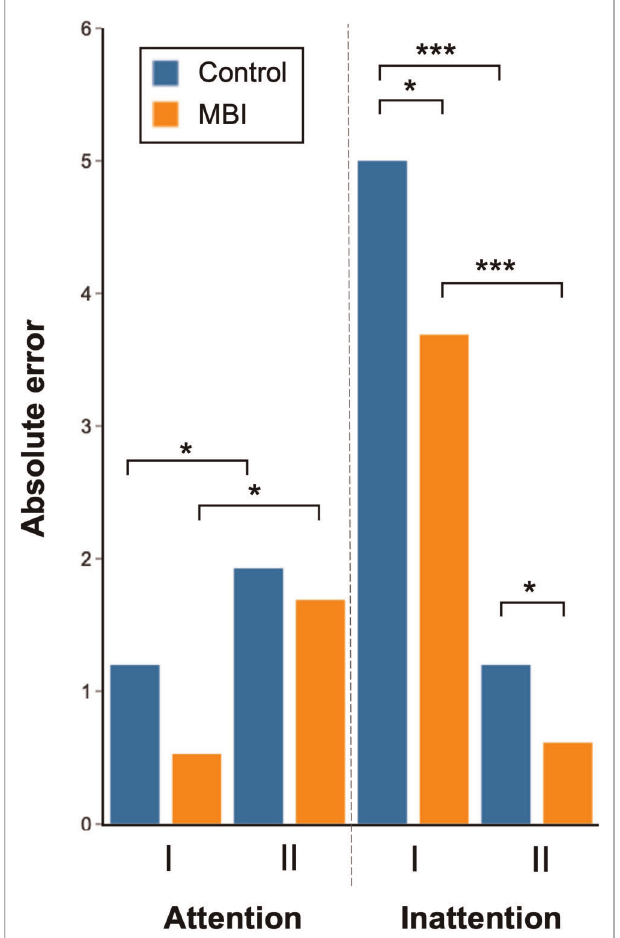
FIGURE 2 | Absolute error scores for attention and inattention tasks for the fi rst (I) and second (II) operative videos. For visualisation purposes the mean absolute error for each group is demonstrated as the height of each bar. (* p ≤ 0.05, *** p